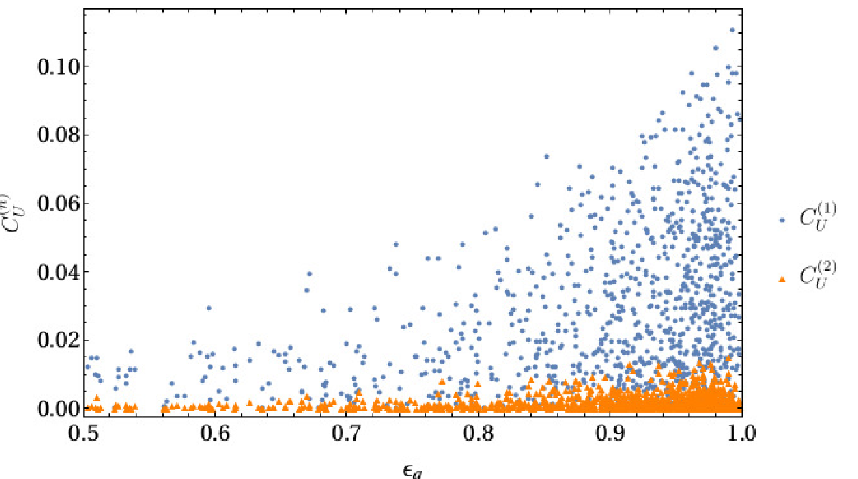
= 1 = 2( vg ( n ) =m ( n ) ) 2 for points inside the benchmark window, as a U L 33 U 1